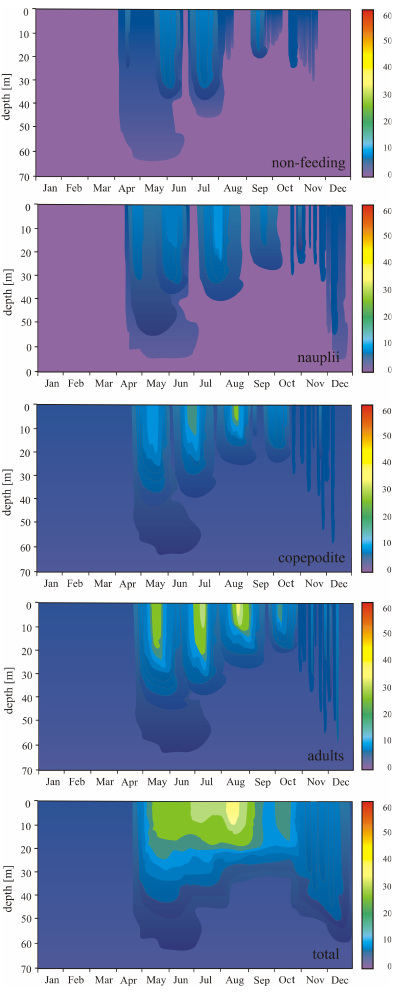
Fig. 5. Simulated annual profiles of four Acartia spp. groups repre- senting: biomasses of eggs, nauplii, copepodites and adults and of total biomass of Acartia spp. (mgCm − 3 ).